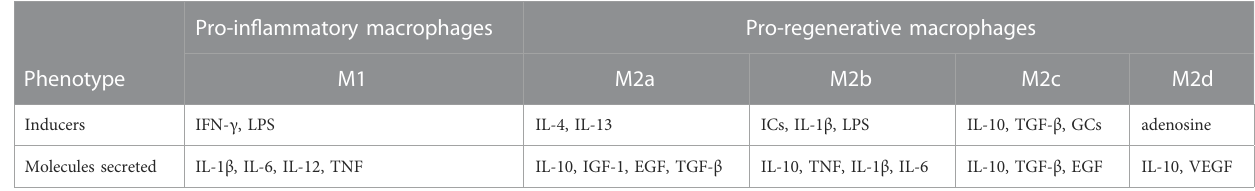
TABLE 1 Macrophage phenotypes described in cultured